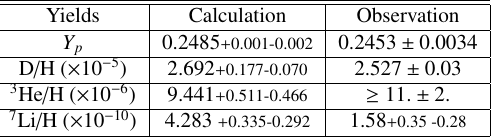
Table 2: Standard BBN yields of light elements updated with input of recent experimental data for nuclear reac- tions. The table includes results based on astronomical observations. The mass fraction for 4 He is historically denoted by Y p . It is taken from Ref. [39]. The deu- terium abundance D / H = (2 . 527 ± 0 . 03) × 10 − 5 [40, 41] is in accordance with 100 Ω b h 2 (BBN) = 2 . 225 ± 0 .